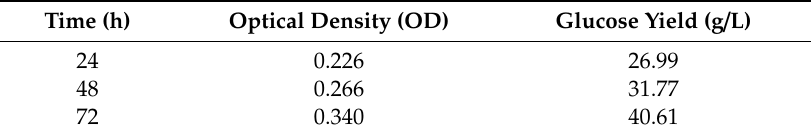
Table 2. Glucose yield during enzymatic